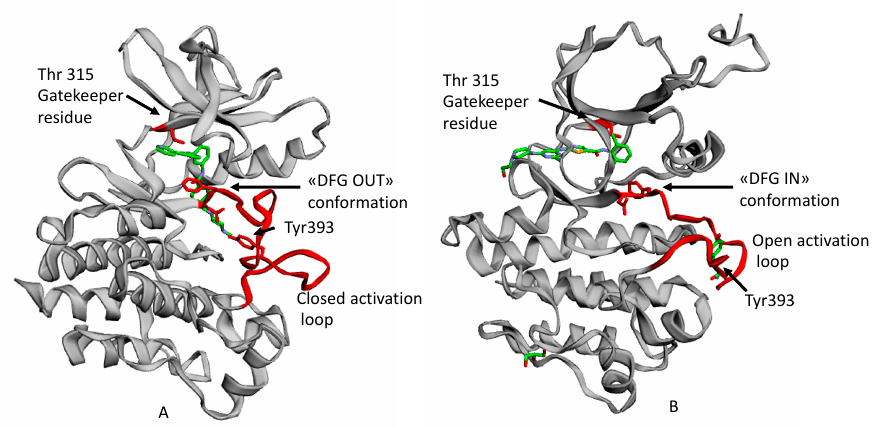
Figure 4. An example of ATP competitive inhibitors: ( A ) X-ray solved the structure of Abl KD in complex with imatinib (PDB entry, 1IEP [29]) with “DFG-OUT” conformation and closed activation loop; ( B ) X-ray solved the structure of Abl KD with dasatinib (PDB entry, 2GQG [43]) with “DFG-IN” conformation and open activation loop [27,44] (The picture is taken from Carofiglio et al. [45]).